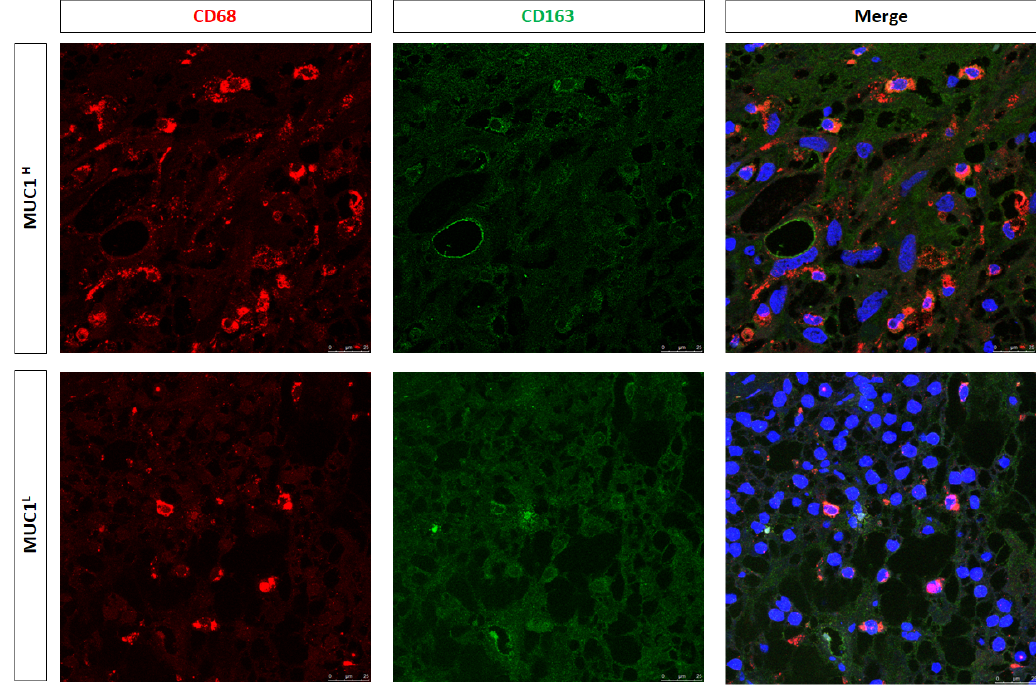
Figure 9. Expression of CD68 and CD163 and their colocalization in neoplastic renal tissues from MUC1 H ccRCC and MUC1 L tumors. MUC1 H ccRCC and MUC1 L